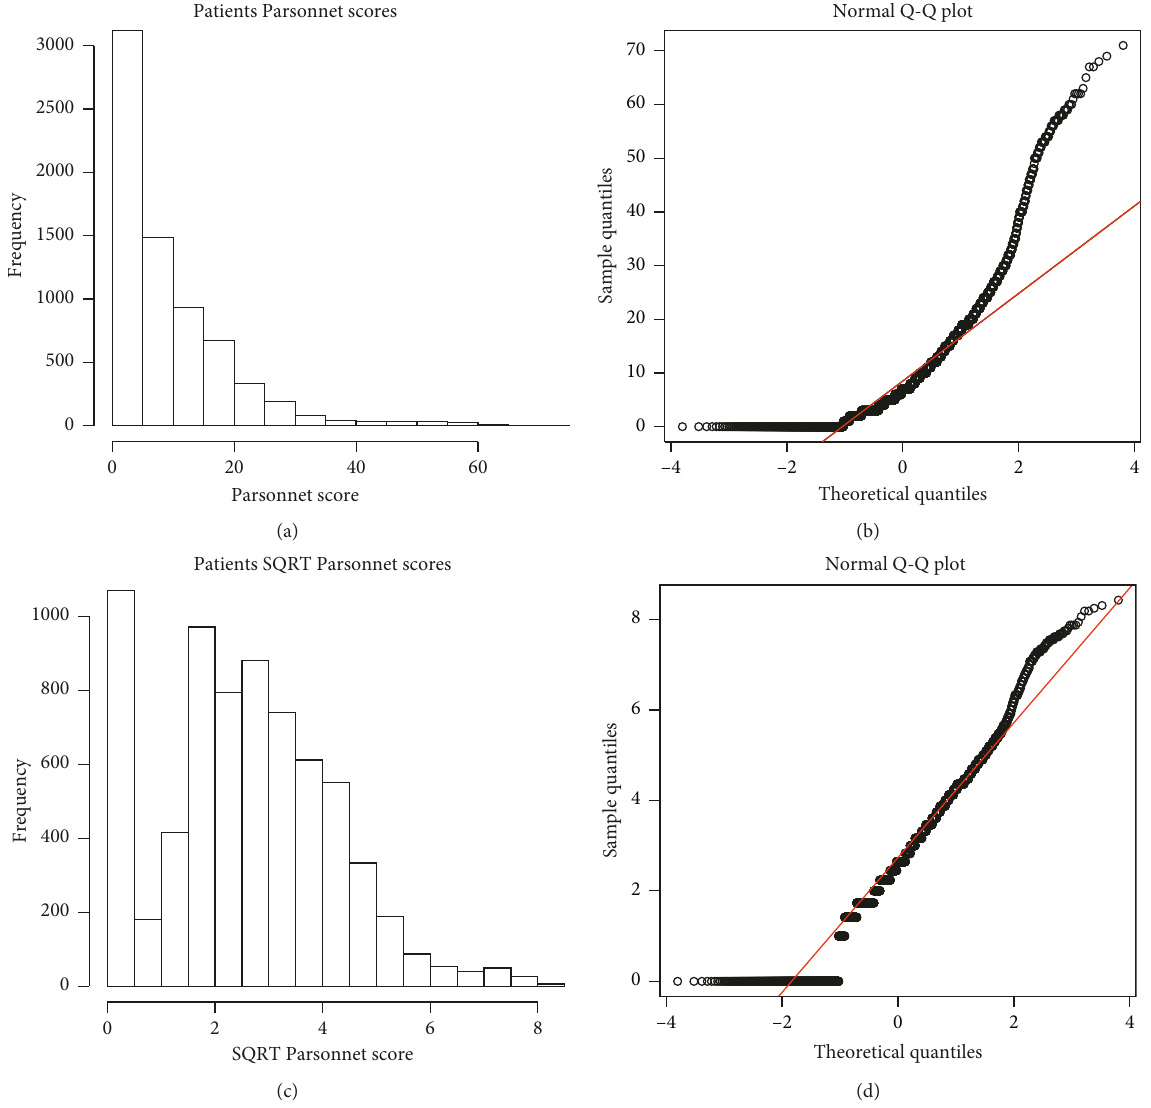
Figure 5: Histogram and Normal Probability Plot of Parssonet Score: first row-untransformed data and second row-transformed data. (a) Histogram. (b) Normal probability plot. (c) Histogram. (d) Normal probability